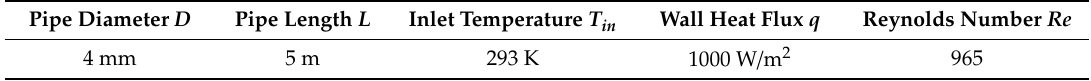
Table 1. Parameters in the computational setup used for the